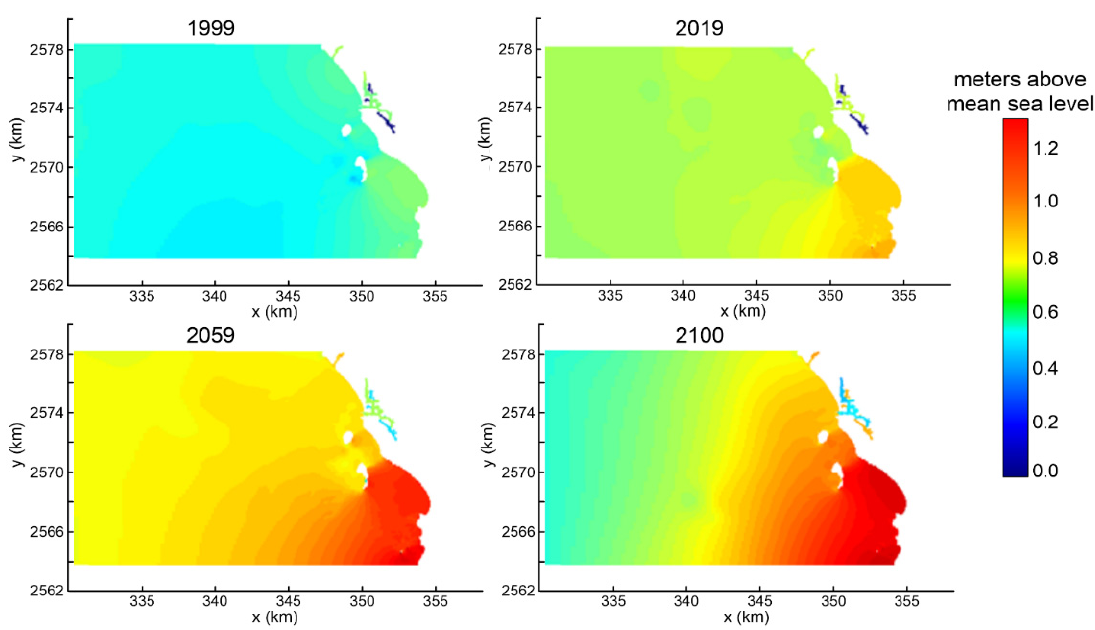
Figure 8. Numerical results for free surface elevations at high tide for 1999 ( top left ), 2019 ( top right ), 2059 ( bottom left ), and 2100 ( bottom right ).